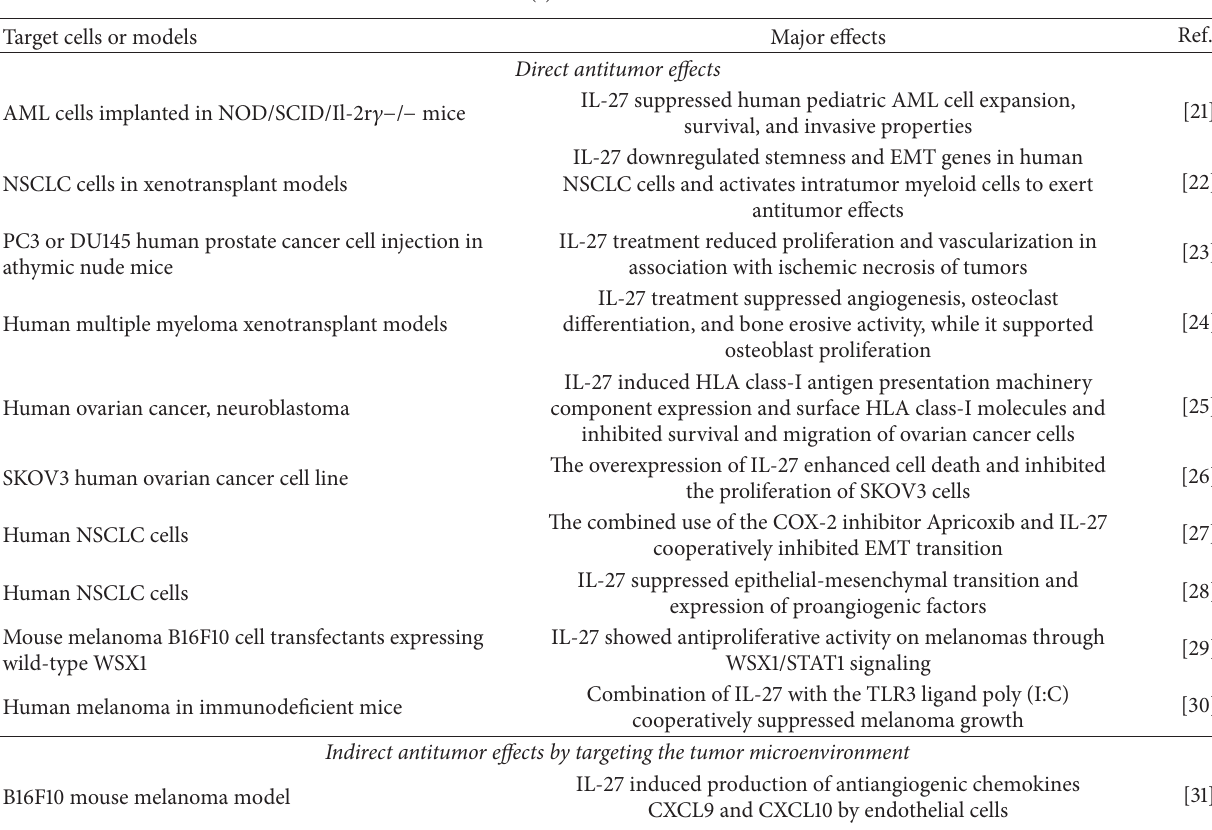
Table 1: Examples of antitumor and protumor effects of IL-27 in different